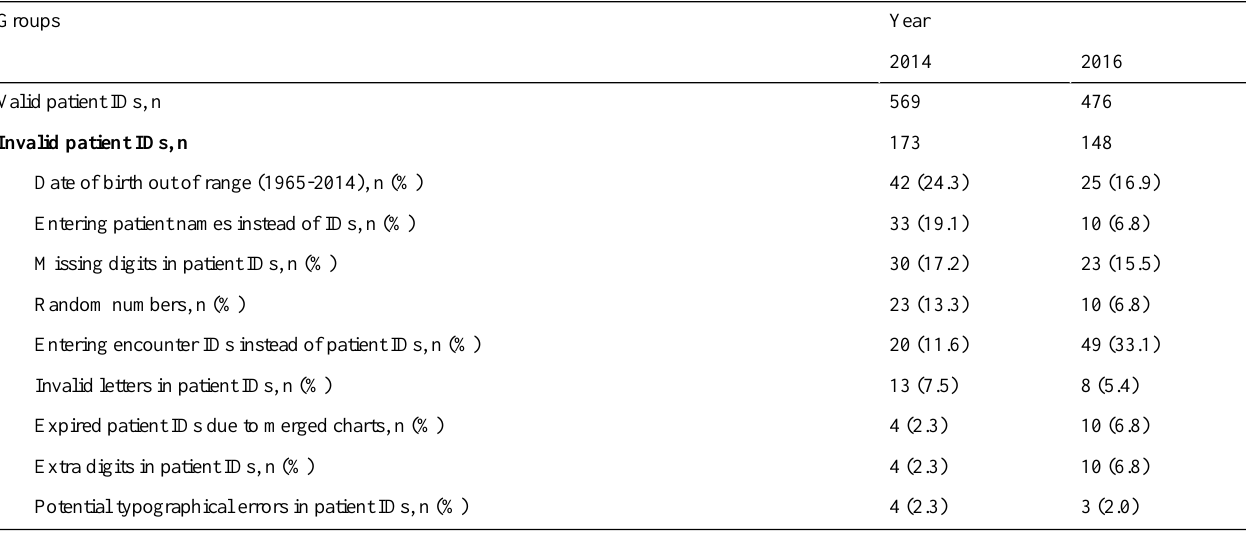
Table 2. Descriptive statistics of patient IDs in smart pump records and categorization of invalid patient